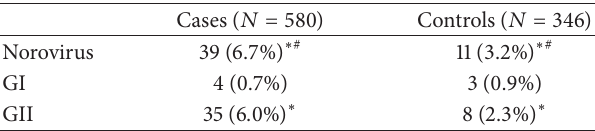
Table 1: Norovirus infection classified by genogroups in stool sam- ples from children (3 months to 5 years) with acute diarrhea (cases) and nondiarrheal controls who attended the National Pediatric Hospital in Phnom Penh, Cambodia, between November 2004 and October 2006.